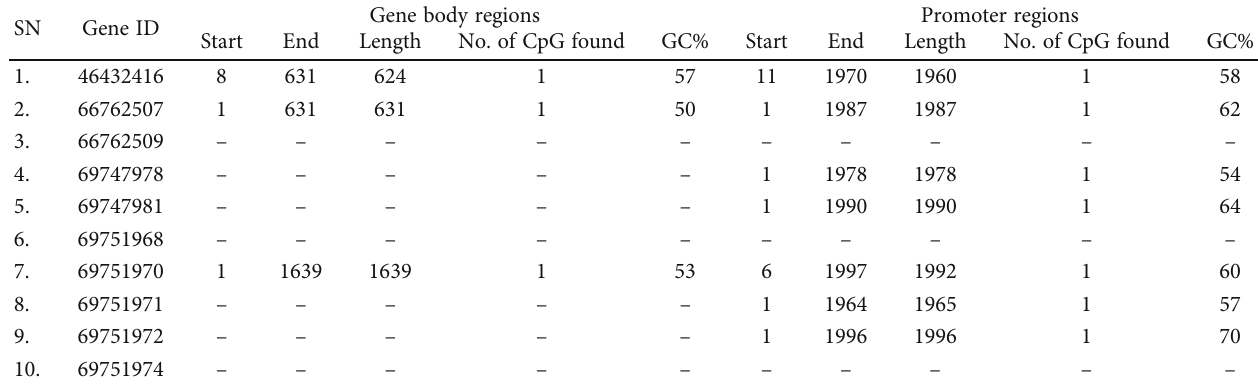
Table 6: CpG islands identi fi ed at both promoter and gene body